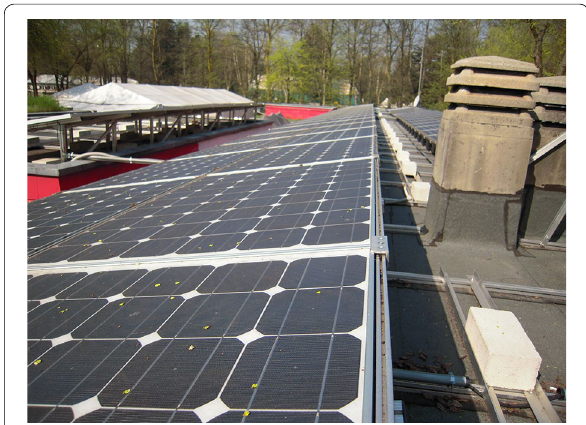
Fig. 23 Photovoltaic panels on the roofing of Circolo Magnolia (Milan, IT): because of a non optimal performance and placement, the project was primarily meant for marketing (picture of the authors)